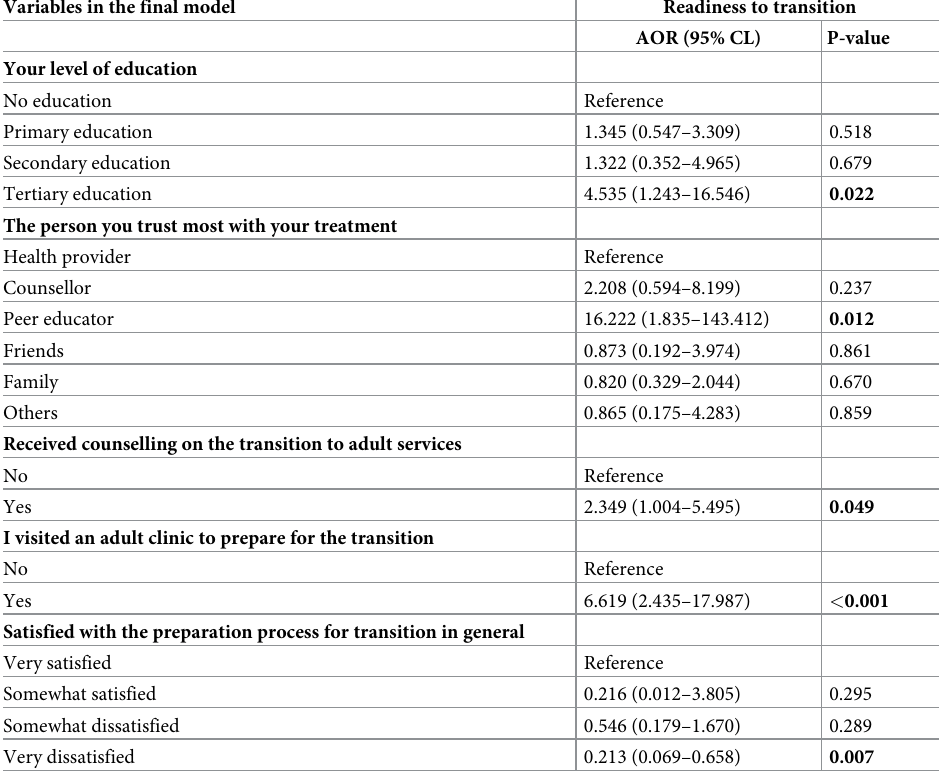
Table 5. Factors associated with readiness to transition of adolescents from adolescent clinics to adult ART clinic in the multivariable logistic regression model. Variables in the final